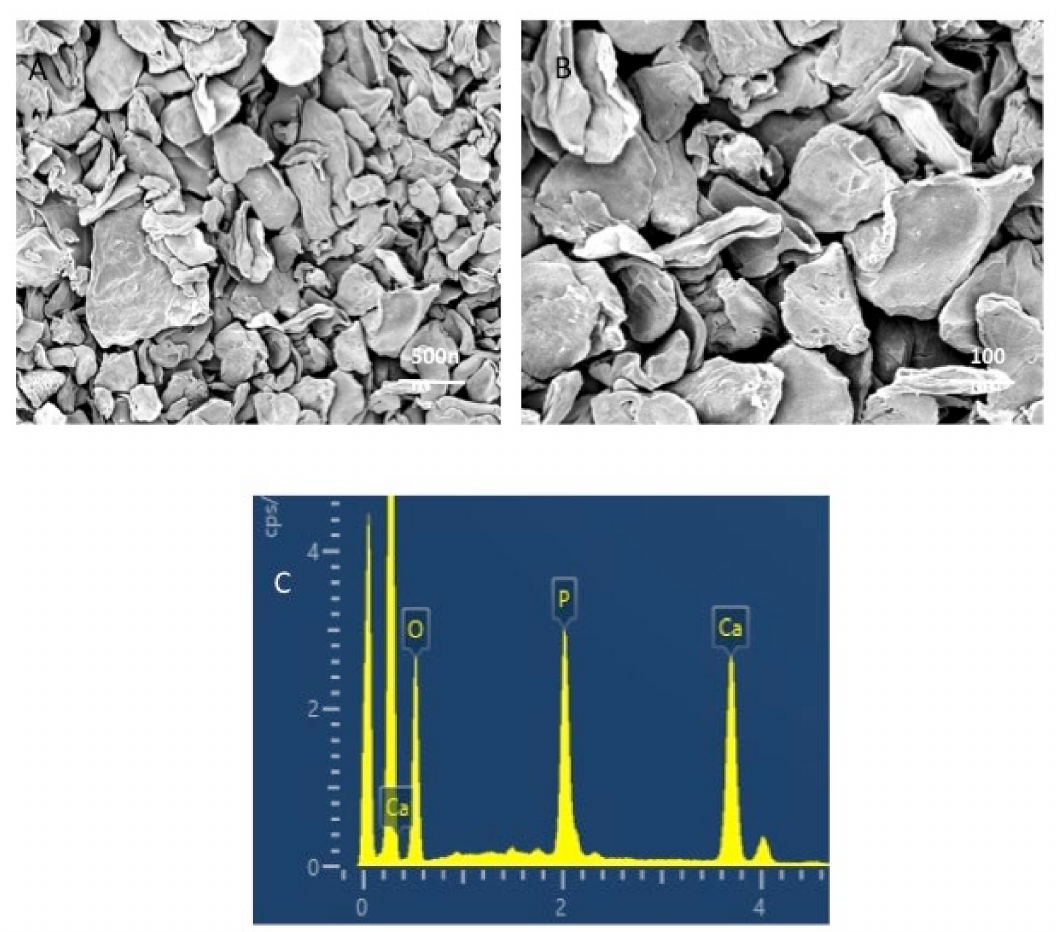
Figure 1. Representative ( A ) low- and ( B ) high-magnification SEM images of β -tricalcium phosphate particles ( β -TCP). The particles indicated agglomerated morphology of irregular sized polygonal crystals ranging from 300 nm to 600 nm. ( C ) Representative electron spectrum particles showing no impurities and mainly containing oxygen ‘O’ (24.2%), phosphorus ‘P’ (17.4%) and calcium ‘Ca’ (60.1%).